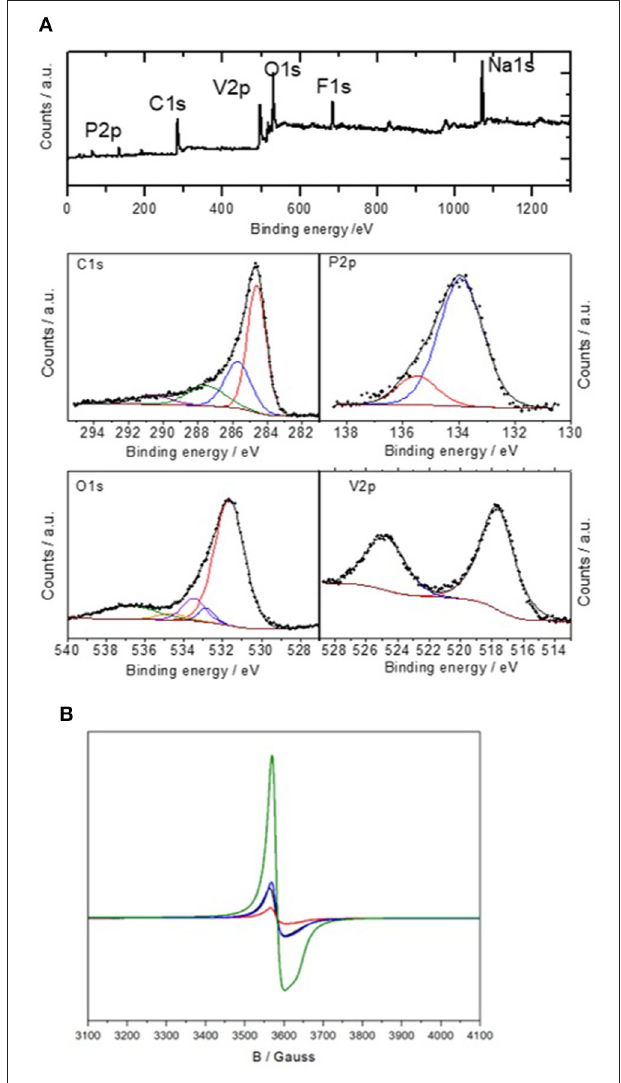
FIGURE 2 | (A) X-ray photoelectron spectra of NVPF-0.5 sample including survey spectrum and sub-spectra at the C1s, P2p, O1s and V2p core levels. (B) Electron Paramagnetic Resonance (EPR) spectra of samples NVPF (black), NVPF-0.2 (red), NVPF-0.5 (blue) and NVPF-1.0 (green).